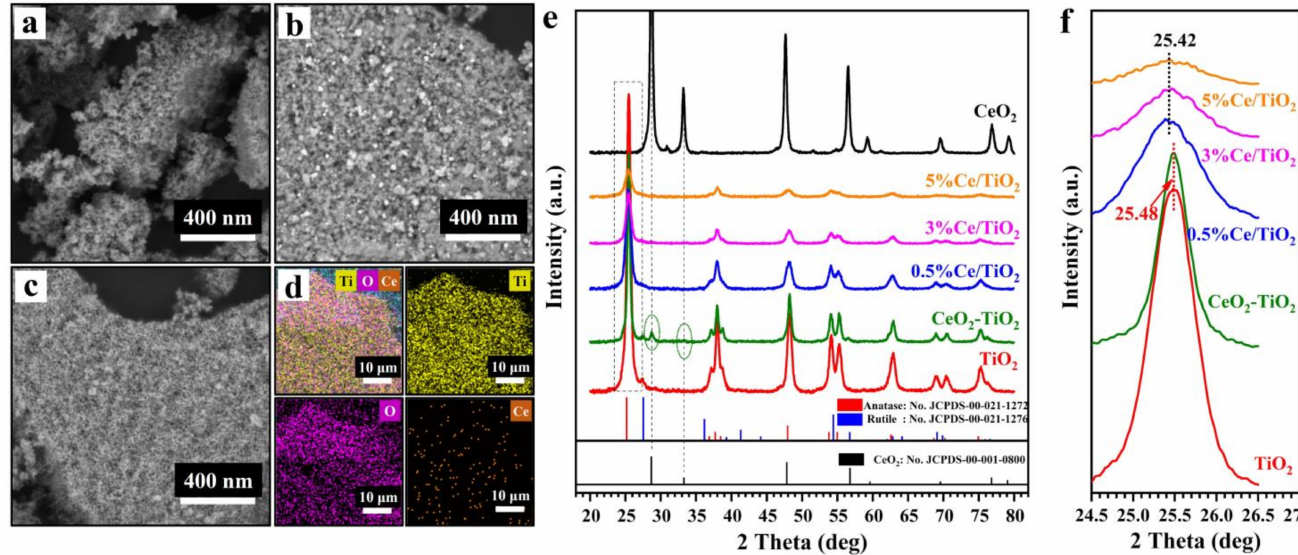
Figure 1. SEM images of ( a ) pure TiO 2 , ( b ) CeO 2 -TiO 2 , and ( c ) Ce/TiO 2 ; ( d ) element mapping images of Ti, O, and Ce in the Ce/TiO 2 sample; ( e ) XRD patterns of the CeO 2 , pure TiO 2 , CeO 2 -TiO 2 mixture, and Ce/TiO 2 samples with different Ce doping contents; ( f ) 23.5–25.0 ◦ refined XRD spectrums of ( e